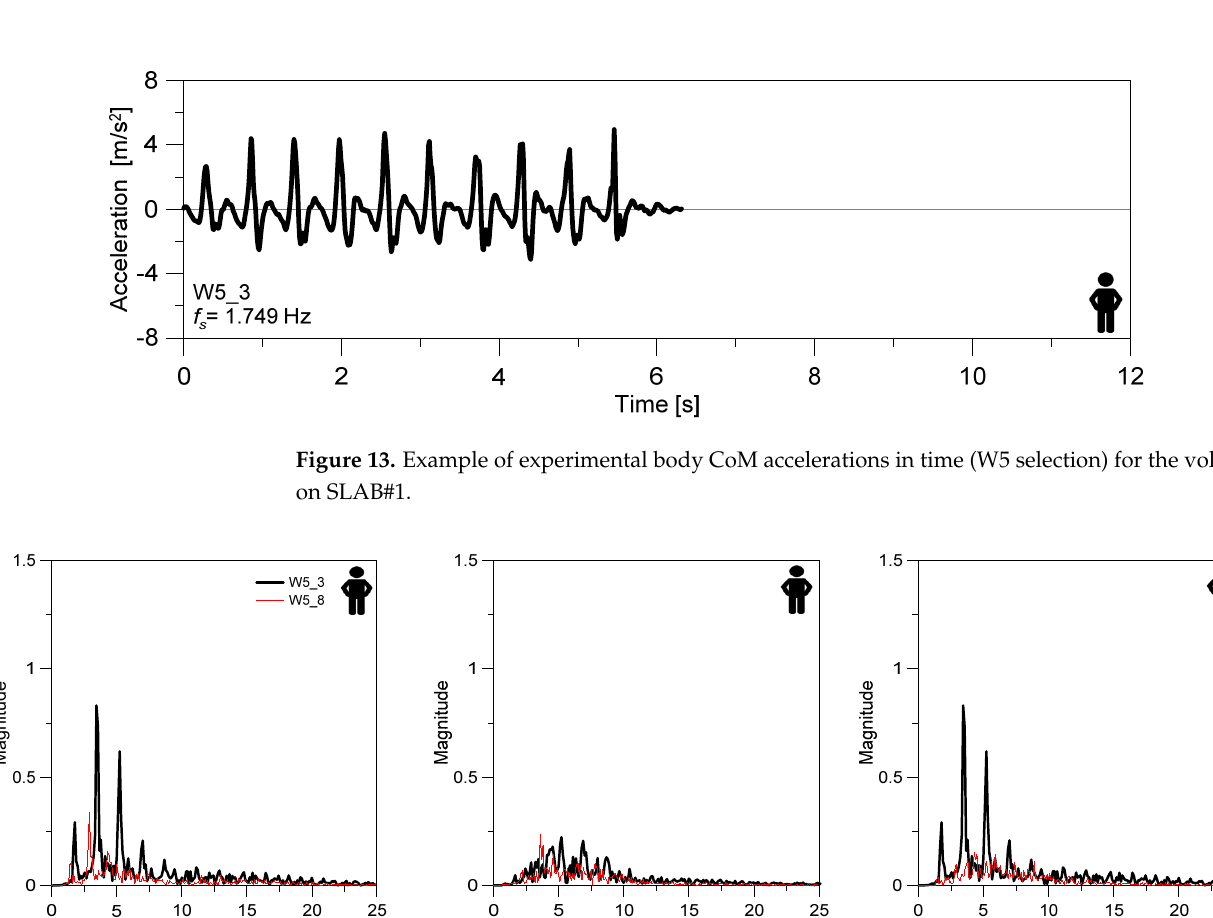
Figure 13. Example of experimental body CoM accelerations in time (W5 selection) for the volunteer on SLAB#1.